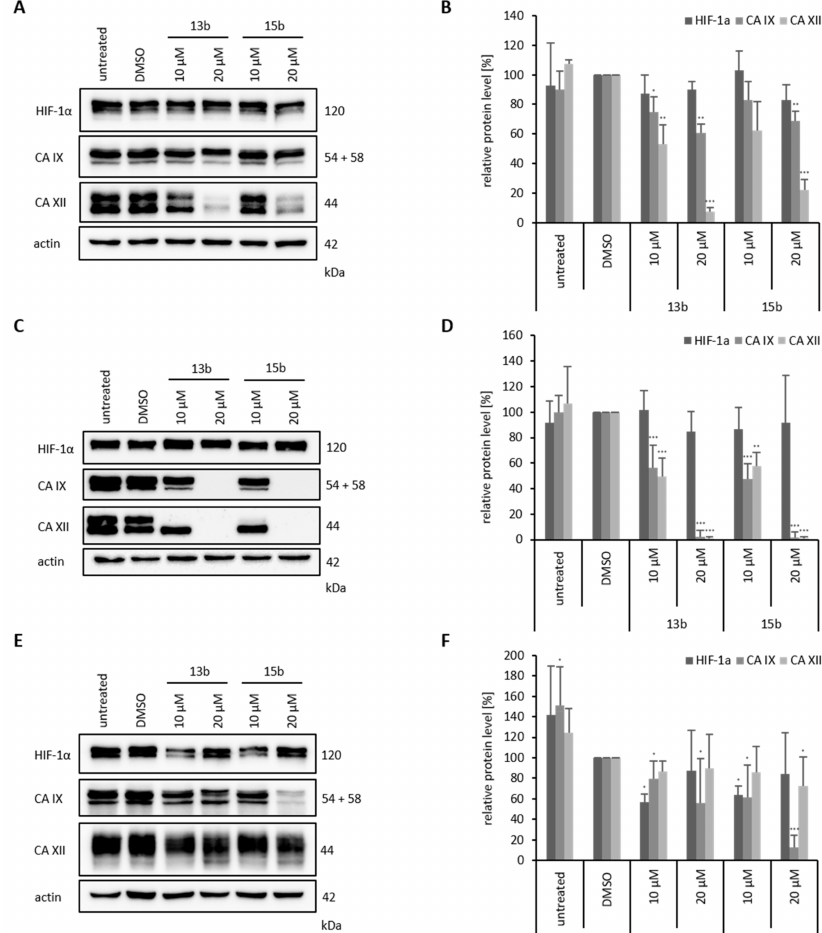
Figure 9. Western blots of HIF-1 α , CA IX and CA XII. Three breast cancer cell lines HS578T ( A + B ), MDA-MB-231 ( C + D ) and MCF-7 ( E + F ) were treated with 10 µ M and 20 µ M 13b and 15b for 24 h under hypoxia (0.1% O 2 ). The cell lysates were analyzed by Western blot, and the protein levels of HIF-1 α , CA IX and CA XII were examined. Actin was used as a loading control. The figure shows representative Western blots ( A , C , E ), but quantification ( B , D , F ) was performed from at least three independent experiments. Significant p values are highlighted with asterisks (* p ≤ 0.05, ** p ≤ 0.01, *** p ≤